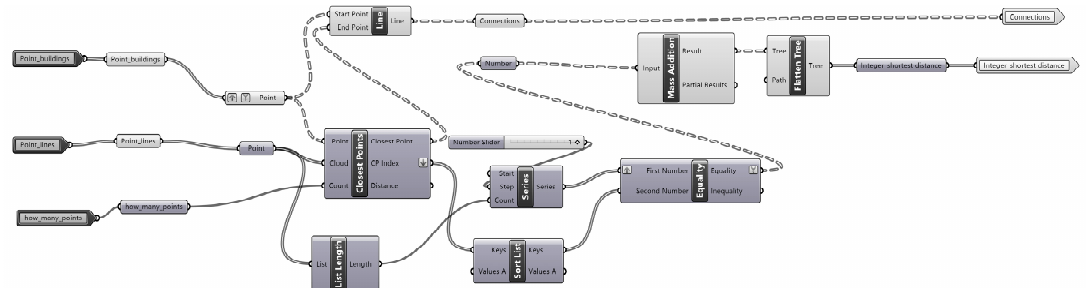
Figure 6. Grasshopper components used to determine the spatial syntactic measure (SSM) value of each POI land use.